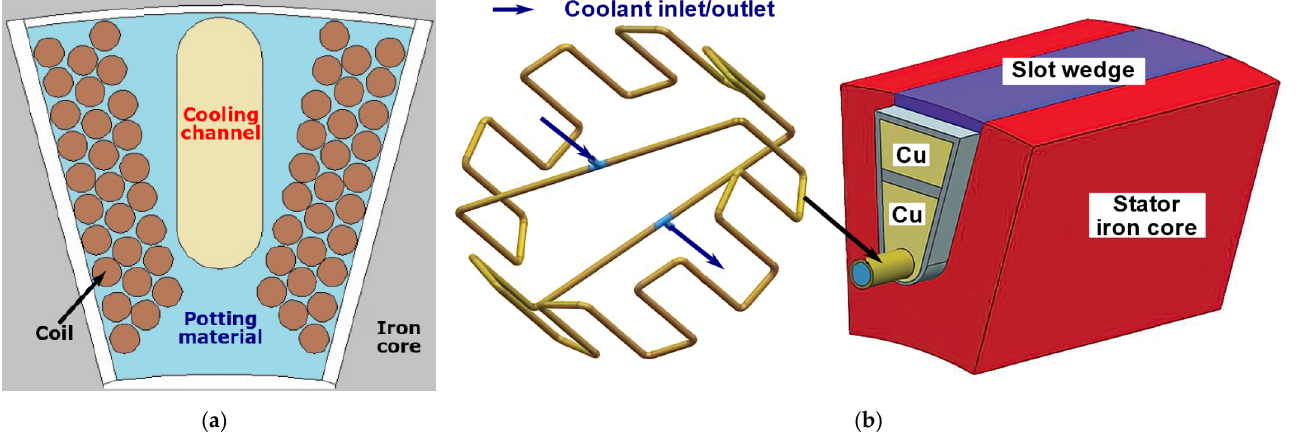
Figure 8. In-slot cooling approaches. ( a ) Liquid cooling channel in the slot of the EM [137]; ( b ) two- way copper pipeline placed in the slots of a PMSM, reproduced with permission from [135]. Copyright the authors 2018.